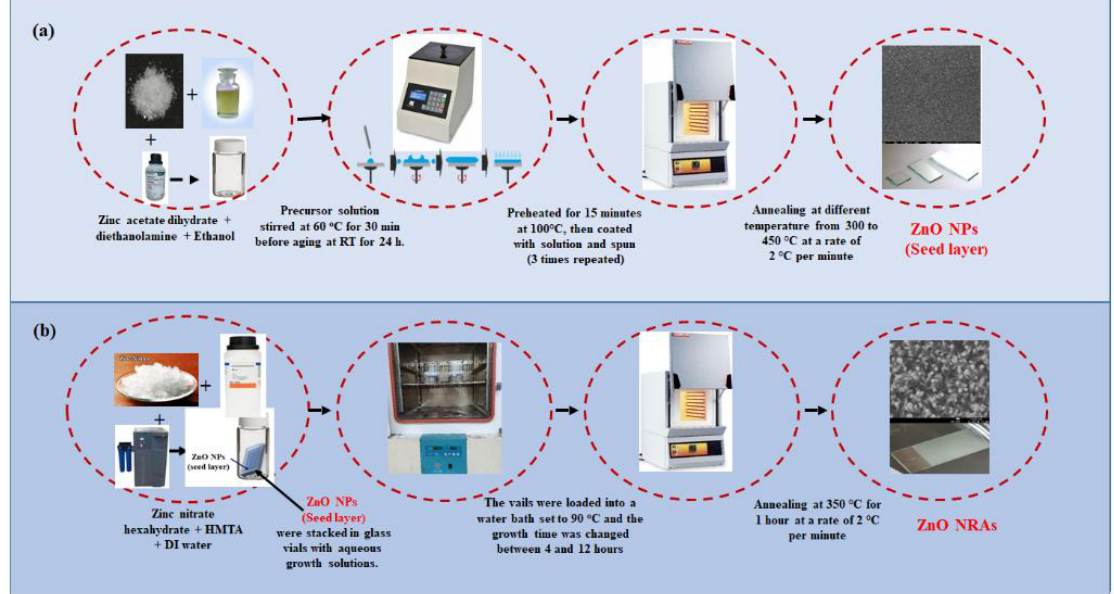
Figure 1. Schematic diagram of ( a ) the fabrication of a ZnO NPs seed layer using sol-gel spin coating and ( b ) the hydrothermal method of synthesized ZnO NRAs.